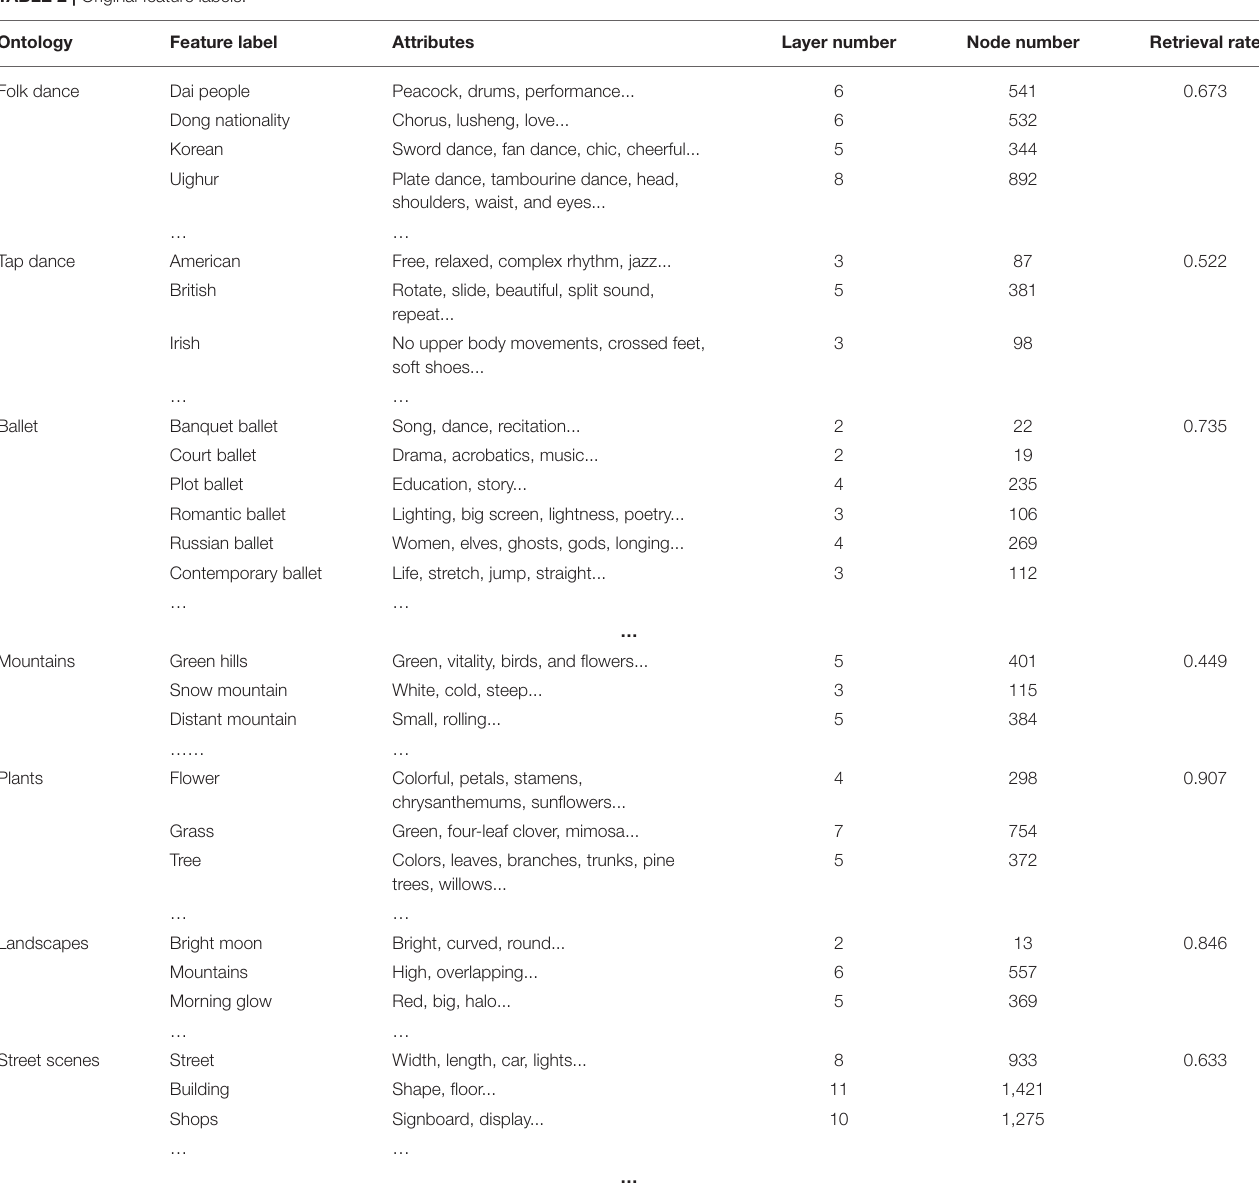
TABLE 2 | Original feature labels.